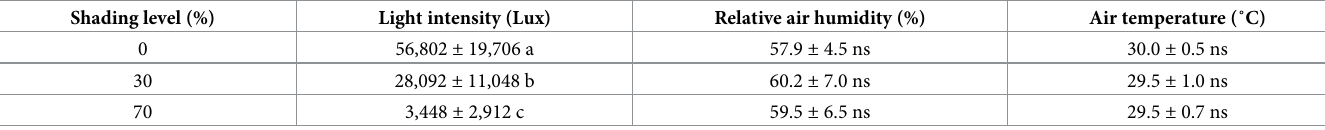
Table 1. Abiotic factors in the